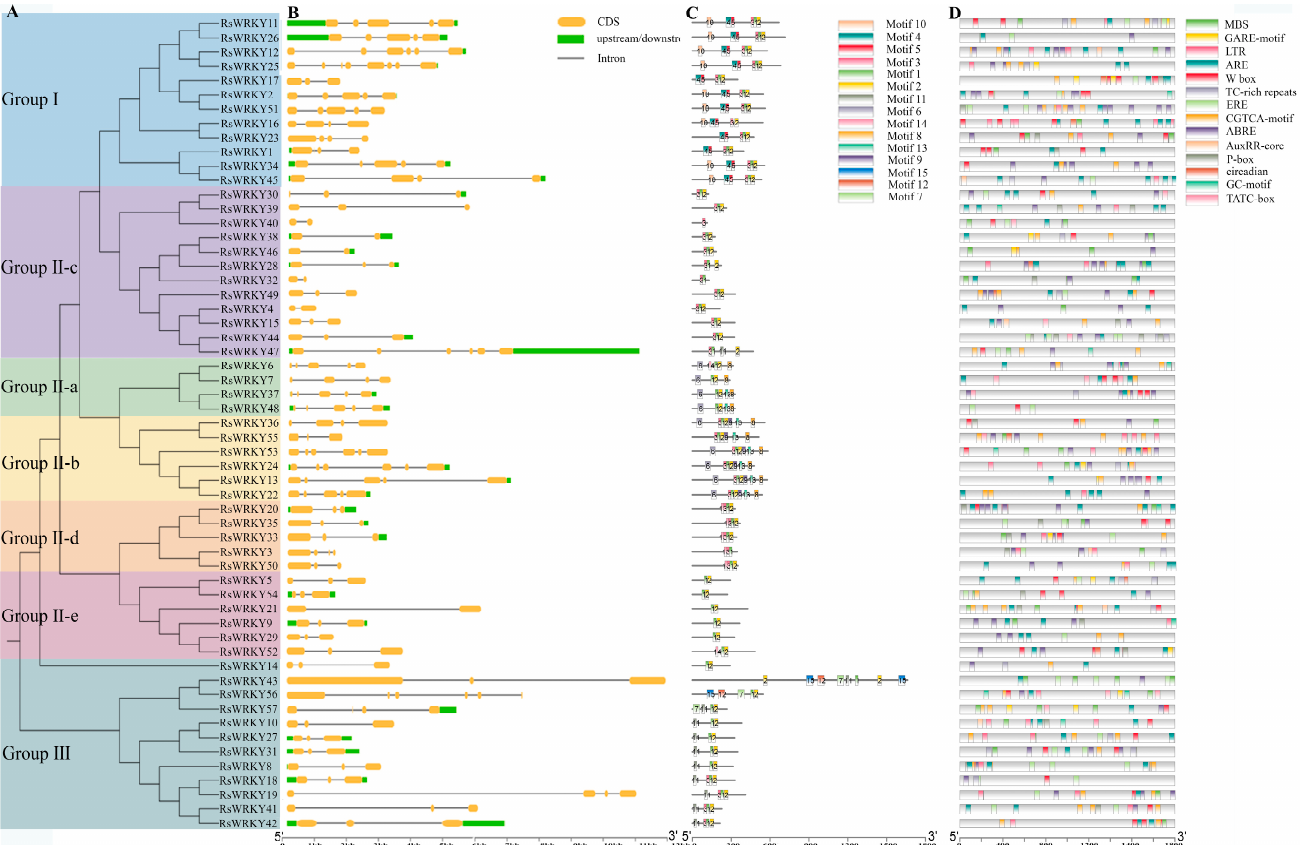
Figure 4. Phylogenetic tree, gene structure, distribution of conserved motif, and cis-regulatory elements of RsWRKY gene family. ( A ) Phylogenetic tree was constructed by MEGA6.0 software and shown on the left. ( B ) Schematic of gene structure was displayed by the gene structure display server, CDSs, UTRs, and introns are represented by orange boxes, green boxes, and black lines. ( C ) The conserved motifs of RsWRKY proteins and different motifs are represented by different color boxes, and numbers. ( D ) Cis-acting element analysis of promoter region of RsWRKY gene family.